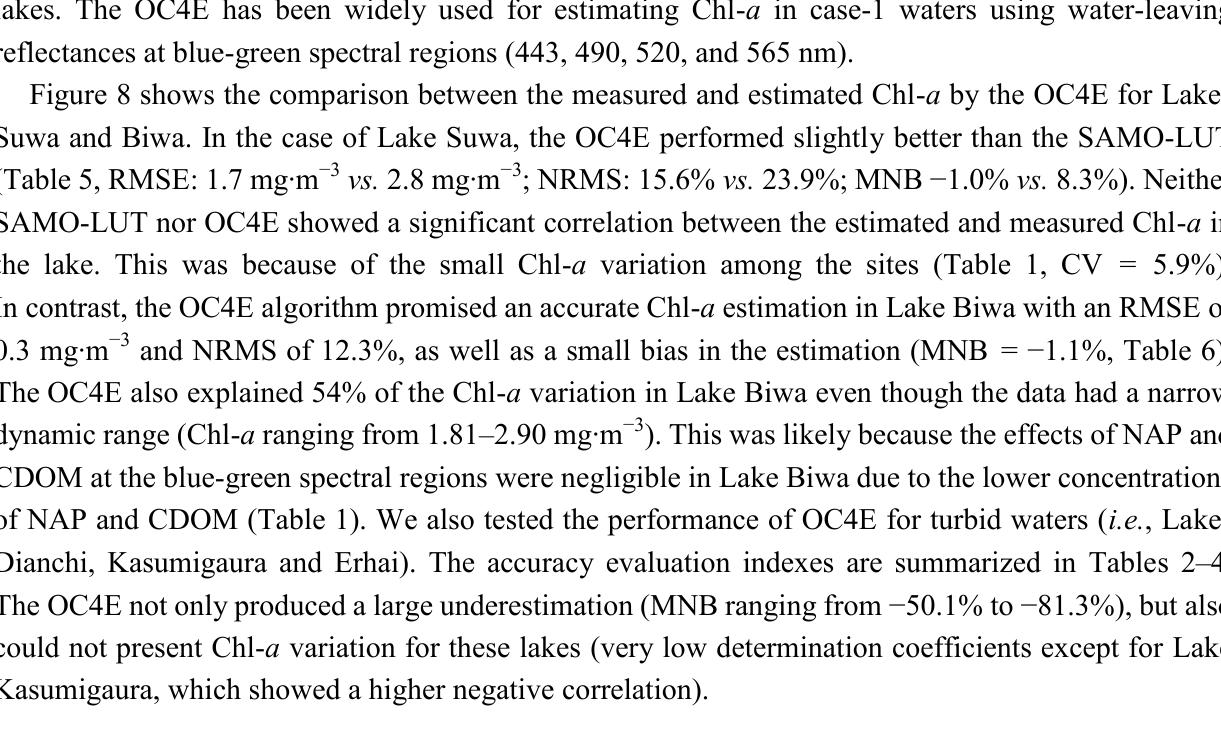
Figure 8. Comparison of the measured and estimated Chl- a by the OC4E algorithm for Lakes Suwa and Biwa,